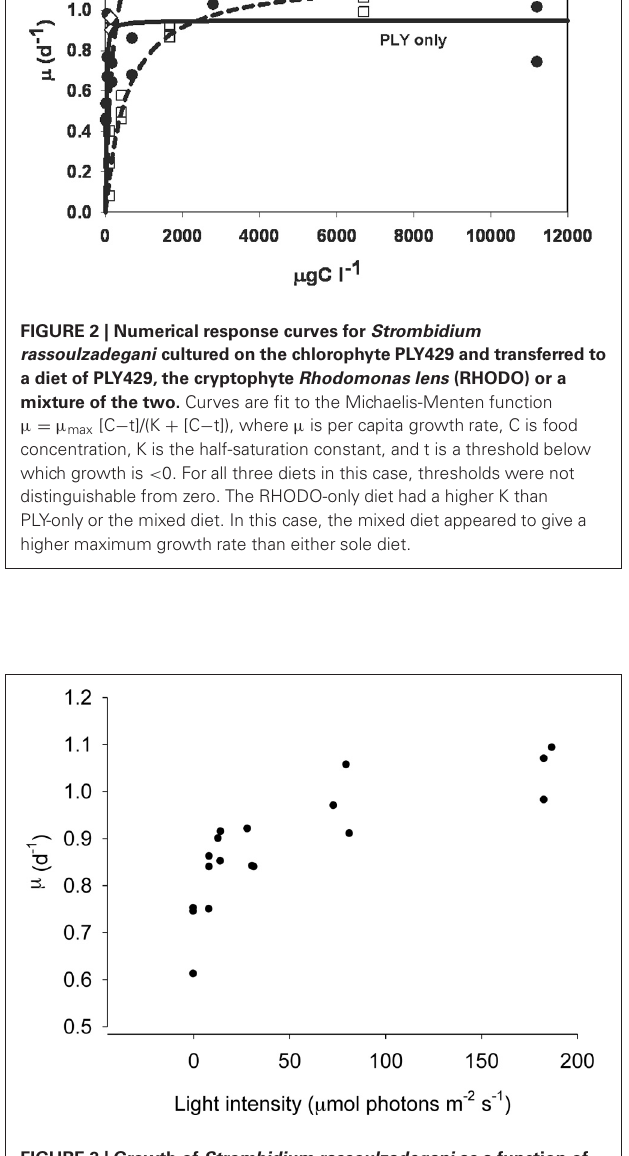
FIGURE 3 | Growth of Strombidium rassoulzadegani as a function of light intensity. Ciliates were grown at 100 µ mol m − 2 s − 1 and transferred to different light intensities without acclimation, ensuring that all chloroplasts were the same age, at a saturating food level of 2 . 5 × 10 4 PLY429/ml.